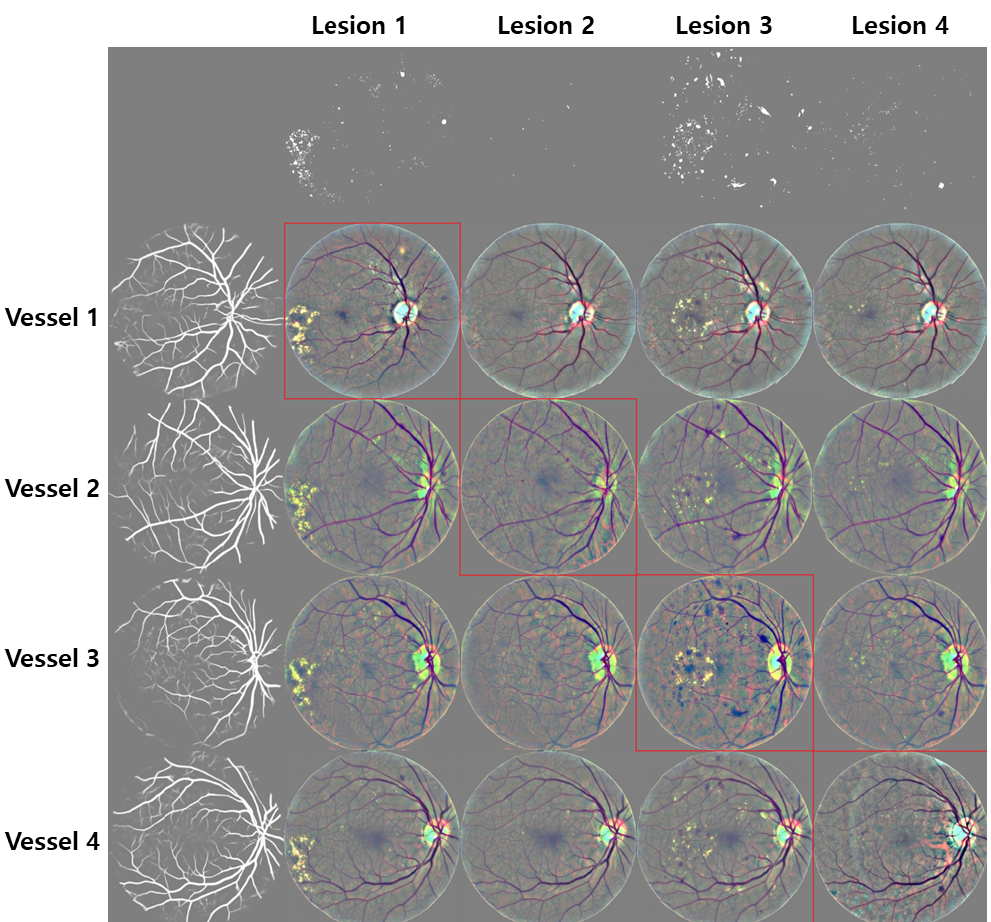
Figure 3. A qualitative comparison of the fundus generator for fundus image synthesis. The fundus generator can synthesize the fundus image by changing the lesion mask with a fixed vessel mask compared to the real fundus images, which are in the red box.